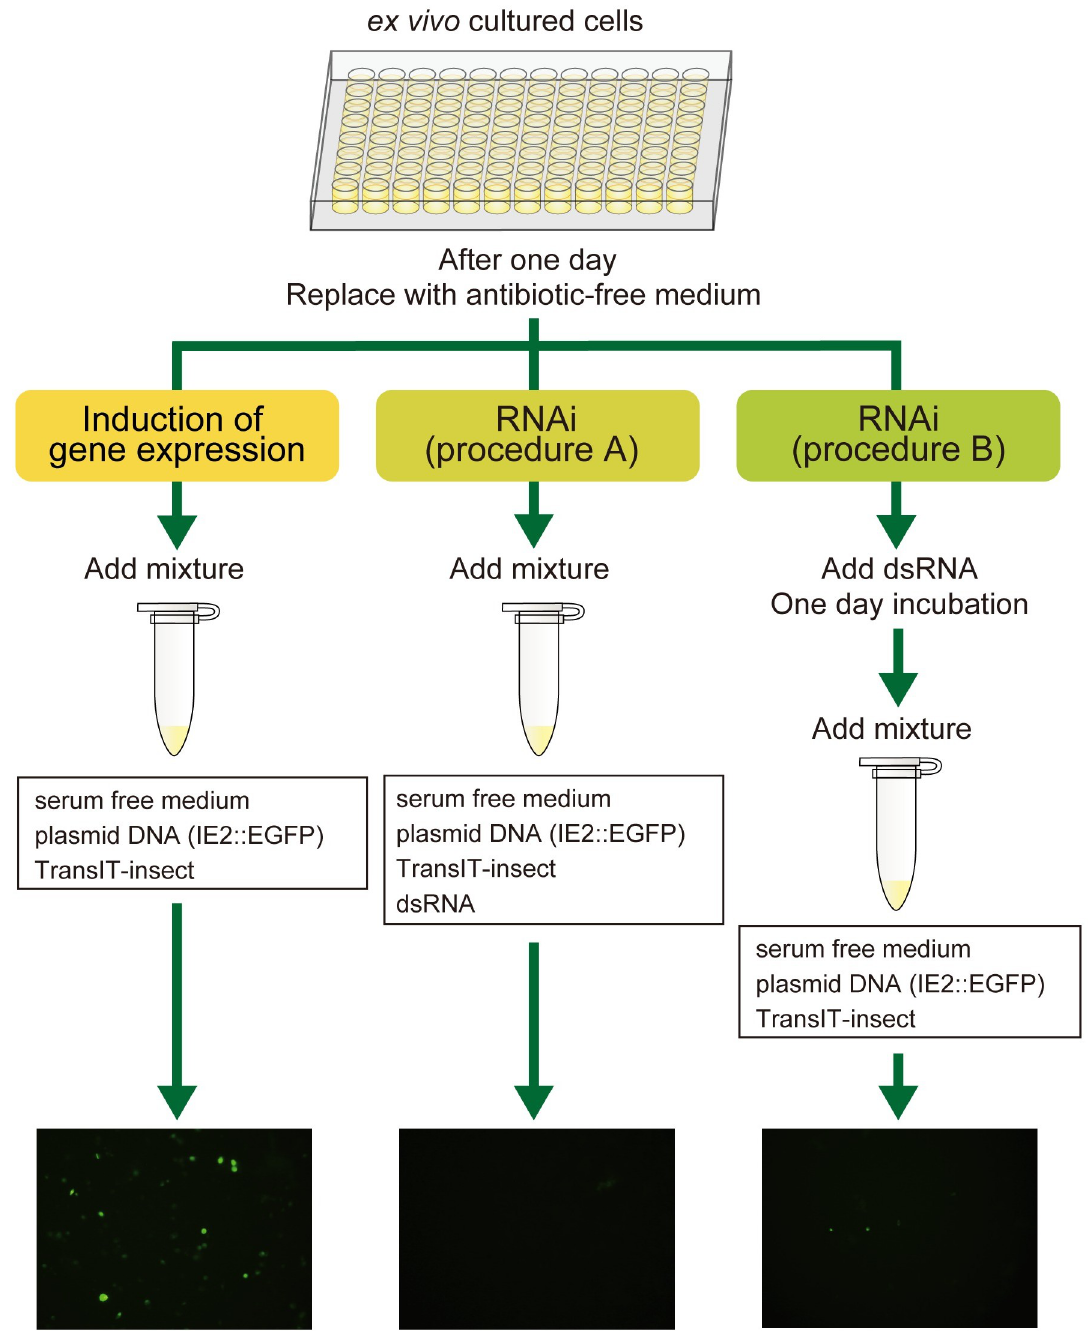
Fig 10. Procedure for inducing and inhibiting gene expression in ex vivo cultured hemocyte cells under optimal conditions. https://doi.org/10.1371/journal.pone.0257770.g010 long as the expression vectors may be transfected into a portion of the cultured cells. Ex vivo cultured hemocyte cells, even with low transfection efficiency, may be used for these assays. Possible applications of ex vivo cultured hemocyte cells will involve the study of factors ( cis and trans elements) that influence transcriptional activity and their utilization as material for